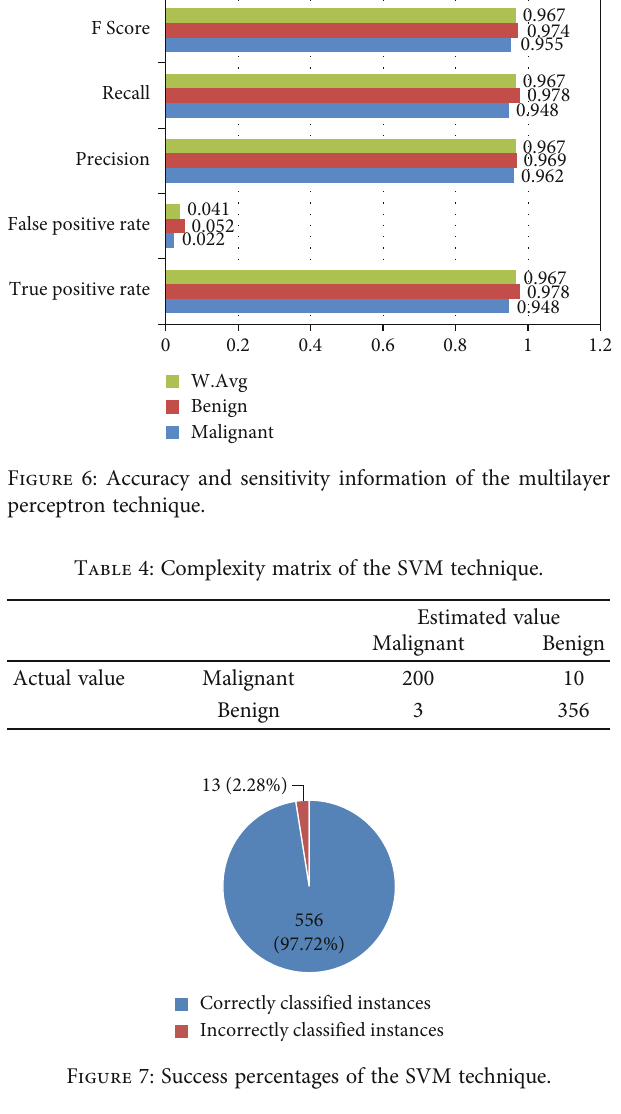
Figure 5: Success percentages of the multilayer perceptron technique.